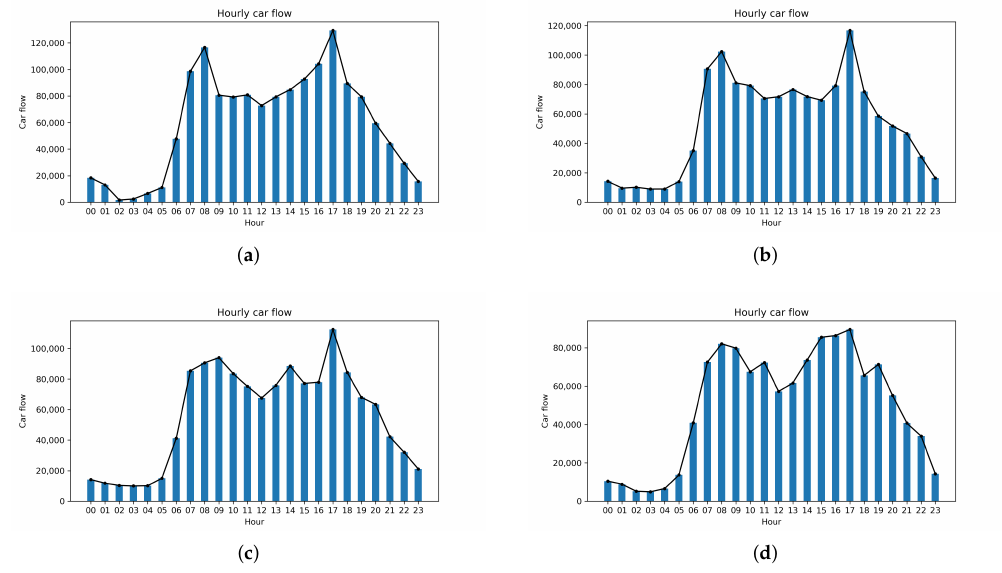
Figure 6. Distribution of temporal travel characteristics on weekdays and weekends. ( a ) Hourly car flow of Monday. ( b ) Hourly car flow of Thursday. ( c ) Hourly car flow of Saturday. ( d ) Hourly car flow of